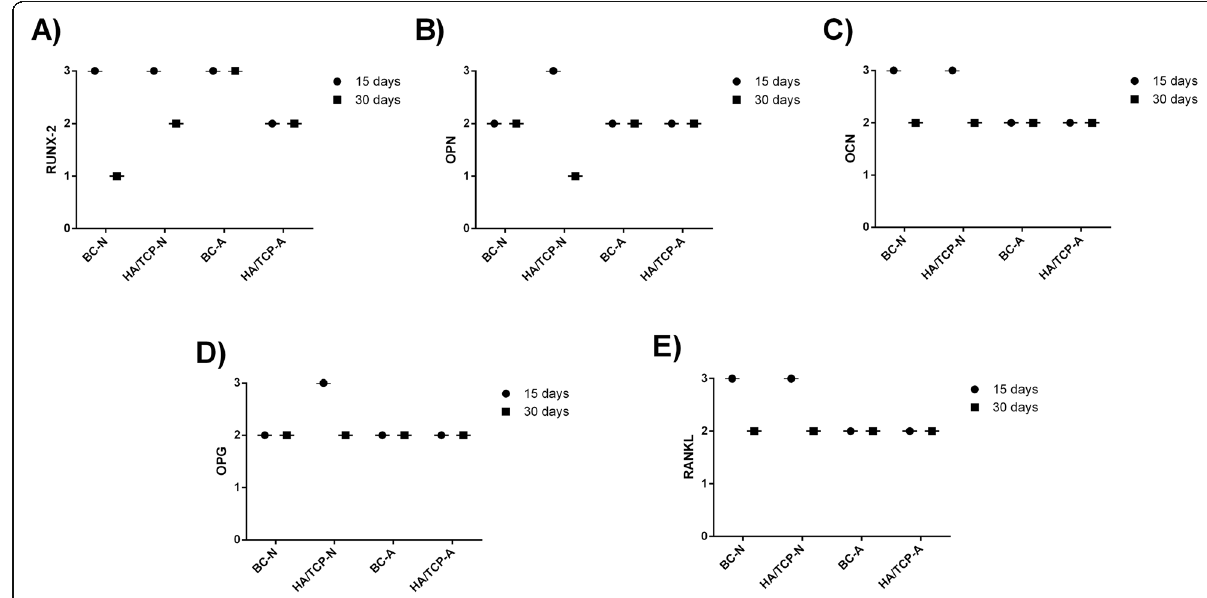
Fig. 6 Representative graphic of immunolabeling of all antibodies. a RUNX2. b OPN. c OCN. d OPG. e